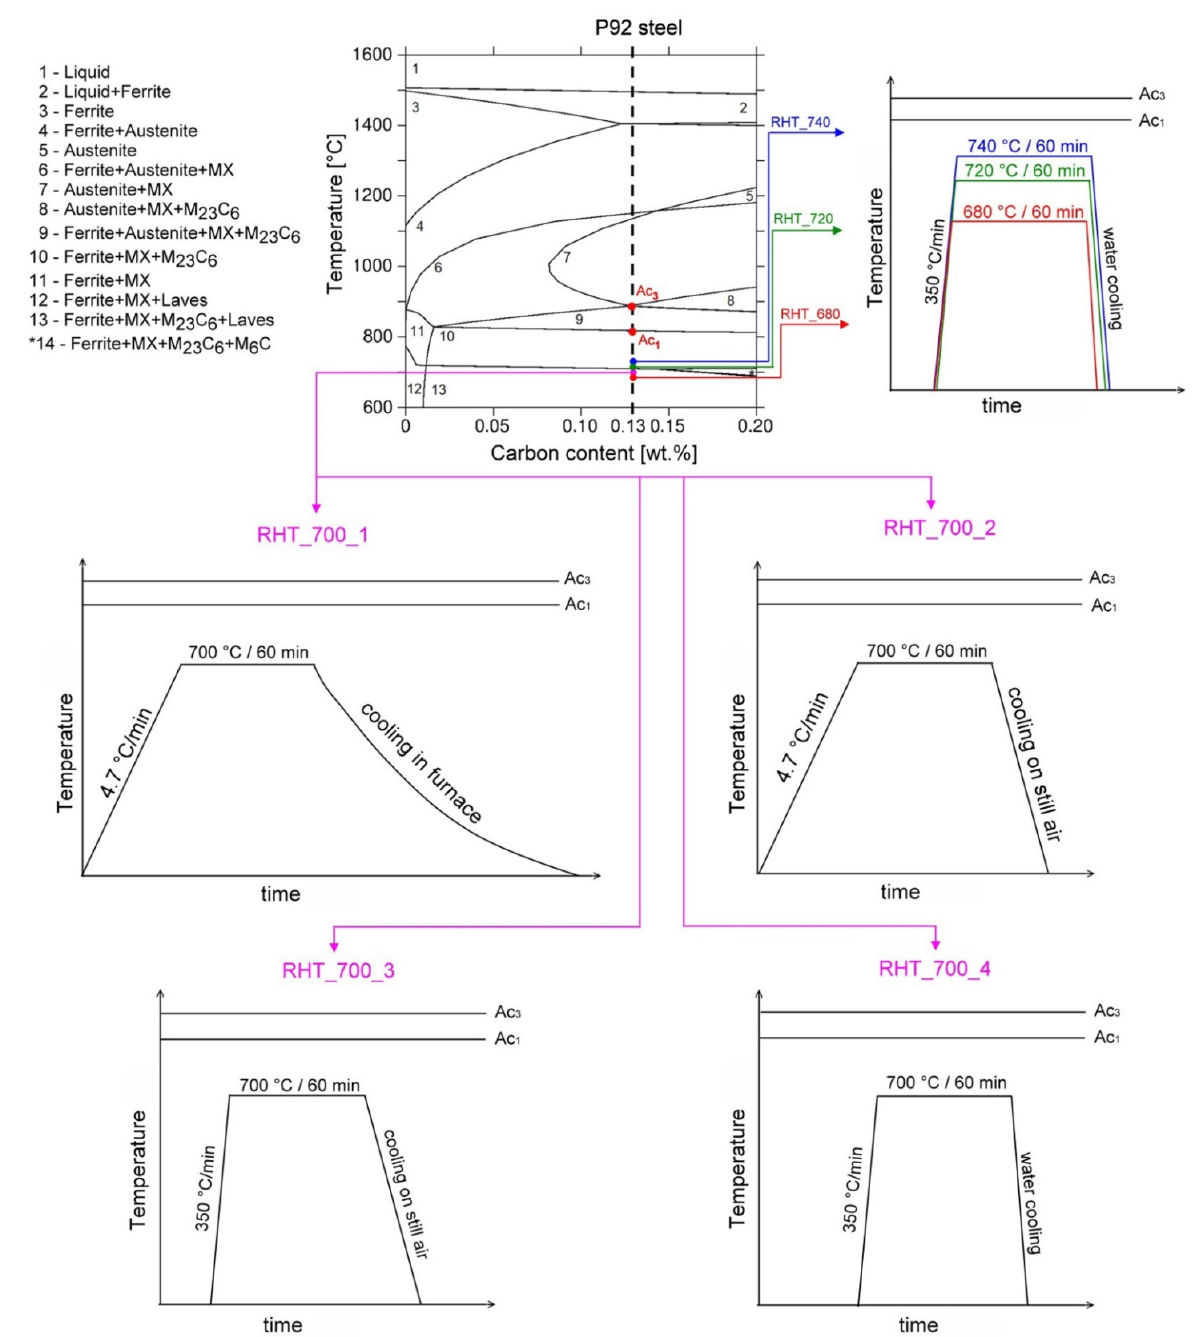
Figure 2. Experimental design philosophy coupling calculated equilibrium phase diagram with schematic illustrations of proposed short-term rejuvenation heat treatments of thermally aged P92 steel. The P92 steel composition is indicated in the diagram by the vertical dashed line at 0.13 wt.% C.